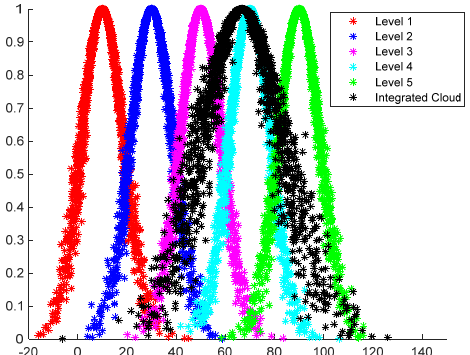
Figure 7. People risk integrated cloud versus standard cloud.